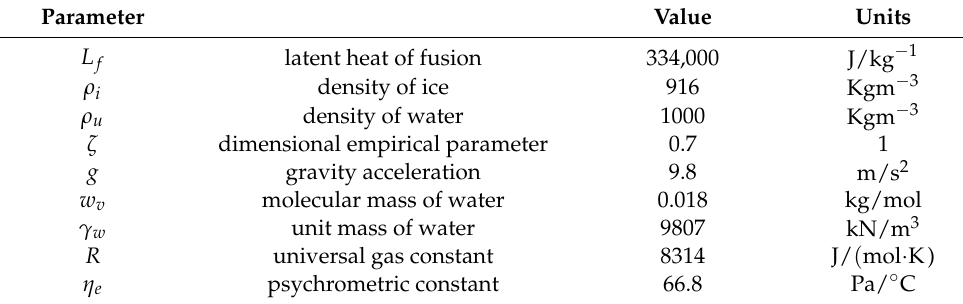
Table 2. Physical constants and parameter values used in the model.